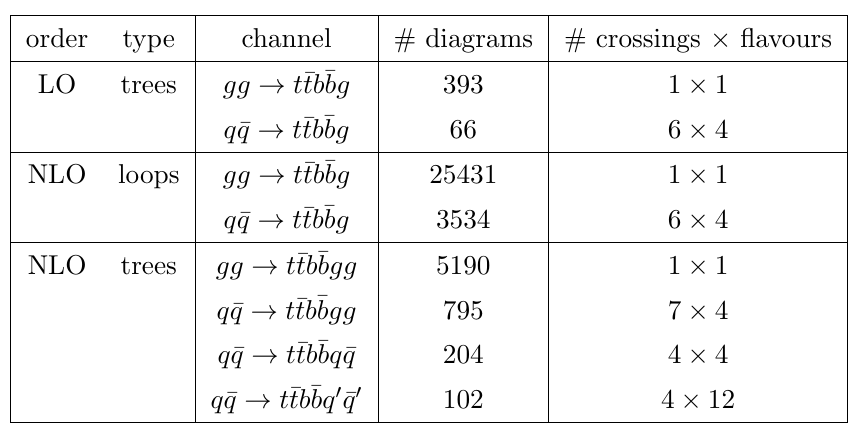
Table 1. Independent partonic channels contributing to pp of crossing-related processes we indicate a representative process, the number of colour-stripped diagrams, and the number of crossings and quark-(cid:13)avour assignments, q; q 0 = u; d; c; s , q OpenLoops , each Feynman diagram corresponds to 3 n 4 colour-stripped diagrams, where n number of quartic gluon vertices in the diagram at hand (typically n 4 = 0).